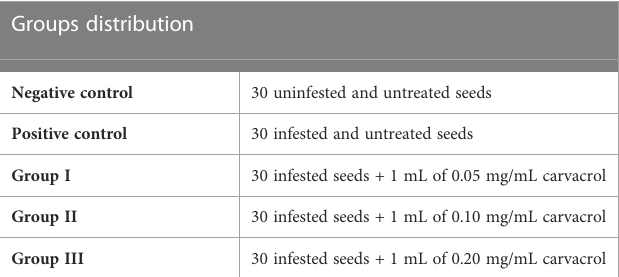
TABLE 1 Experimental protocol for the carvacrol treatment in vitro